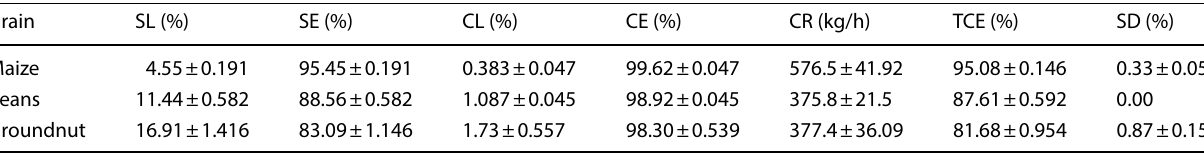
Table 2 Results for the parameters for the different grains damageGrain SL (%) SE (%) CL (%) Maize Beans Groundnut SL separation loss, SE separation efficiency, CL cleaning loss, CE cleaning efficiency, CR cleaning rate, TCE total cleaning efficiency, SD seed